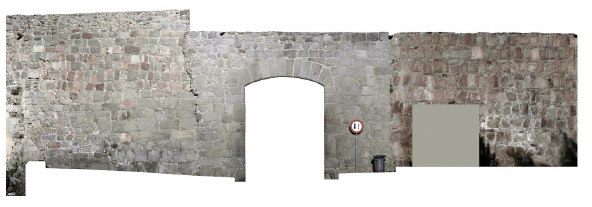
Figure 6. Orthophoto of sector ​